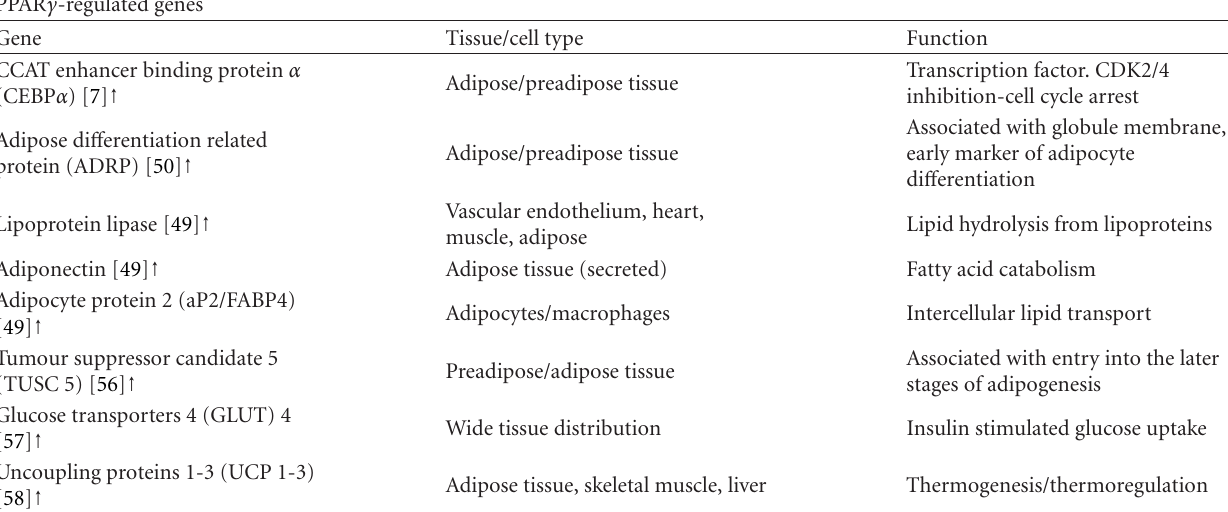
Table 1: PPAR γ -regulated genes involved in adiogenesis, glucose uptake, and thermoregulation ( ↑ positive regulation; ↓ negative regulation). PPAR γ -regulated